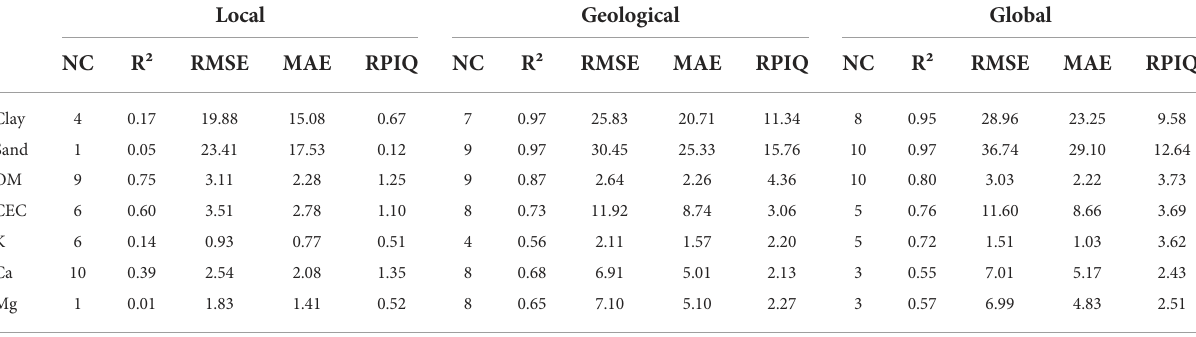
TABLE 1 Results of online prediction of soil clay, sand, organic matter (OM), cation exchange capacity (CEC), and calcium (Ca) using principal components regression (PCR) models developed for the different calibration strategies of only in- fi eld samples (local), adding samples from the same geological region (geological), and from different geological regions (global). Local